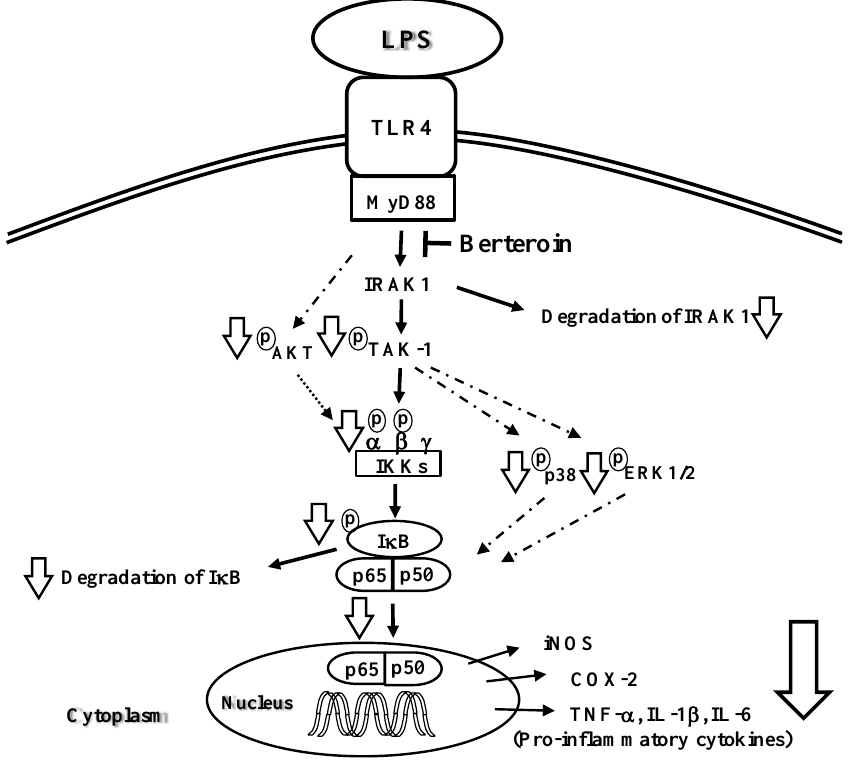
Figure 7. Proposed mechanisms underlying the anti-inflammatory effects of berteroin. Berteroin inhibits IL-1 receptor-associated kinase (IRAK1) degradation, which results in decreased phosphorylation of transforming growth factor β activated kinase-1 (TAK1) leading to the reduction of IκB kinase (IKK), p38 mitogen activated protein kinase (MAPK), and extracellular regulated kinase (ERK)1/2 phosphorylation and subsequent reduction of IκB phosphorylation and degradation. Decreased AKT phosphorylation also contributes to the reduction of IKK activation. The resulting high levels of IκB prevents p65 translocation from the cytosol to the nucleus thereby preventing transcription of inducible metric oxide synthase (iNOS), cyclooxygenase (COX)-2, tumor necrosis factor (TNF)-α, interleukin (IL)-1β, and IL-6 leading to a decreased inflammatory